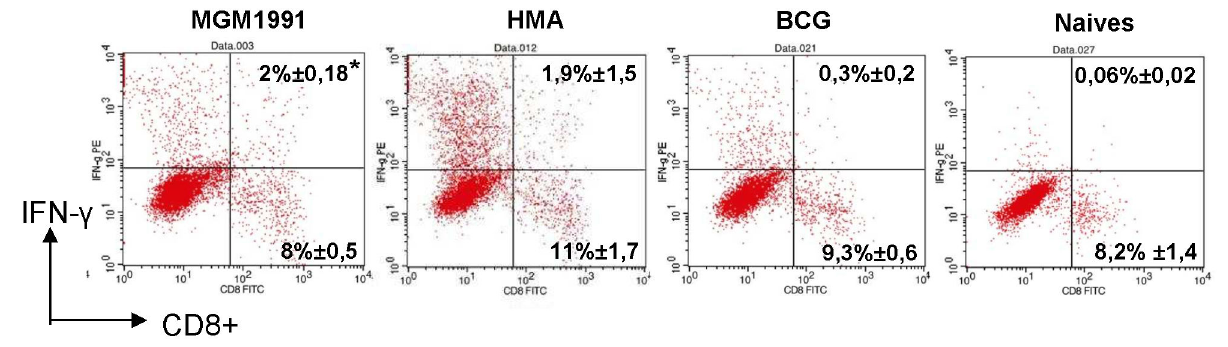
Figure 5. Mycobacteria specific intracellular IFN-γ production in CD8+ T spleen cells of mice vaccinated with MGM1991, HMA or BCG vaccine at 14 weeks after immunization. ICS staining of CD8+ spleen cells from C57BL/6 mice vaccinated 14 weeks before with 5x10 4 CFU of MGM1991, HMA or M. bovis BCG by the subcutaneous route or from unvaccinated (naïve) mice. Mean % of positive cells in each quadrant (of 3 mice tested individually in each group). * p <0,05 MGM1991 vs BCG (Mann-Whitney test).